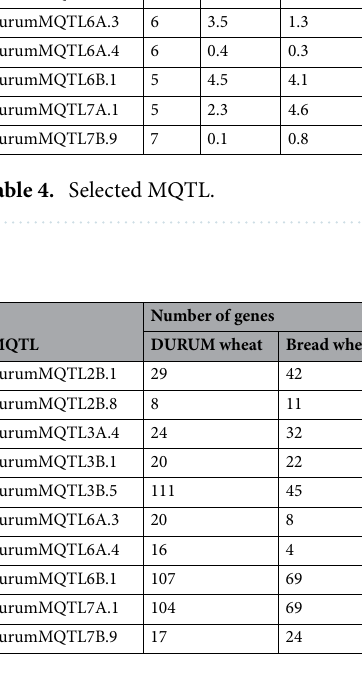
Table 5. Number of genes detected for each